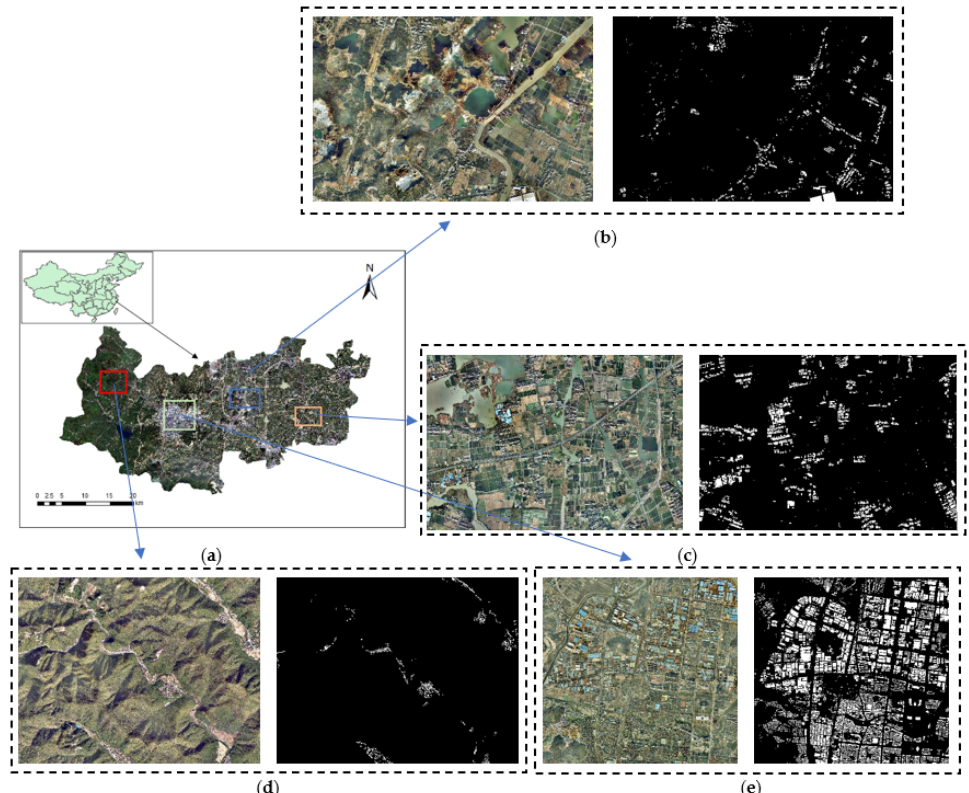
Figure 1. Part of the study area. ( a ) The location of Deqing County in China; ( b ) hilly area of Deqing County; ( c ) plain area of Deqing County; ( d ) mountain tombs in Deqing County; ( e ) dense housing area in Deqing